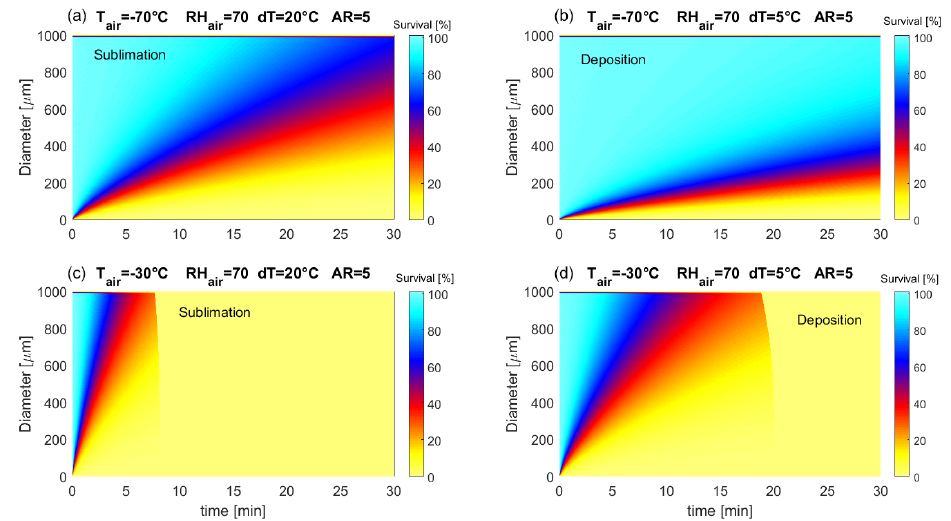
Figure 9. Evolution of an originally uniform PSD of ice spheroids ( D = 0–2000µm, AR = 5) under different atmospheric conditions (RH air is a secondary factor affecting the results, shown here for RH = 70%). (a, c) Sublimation period; (b, d) deposition period. (a, b) Winter, (c, d) summer.